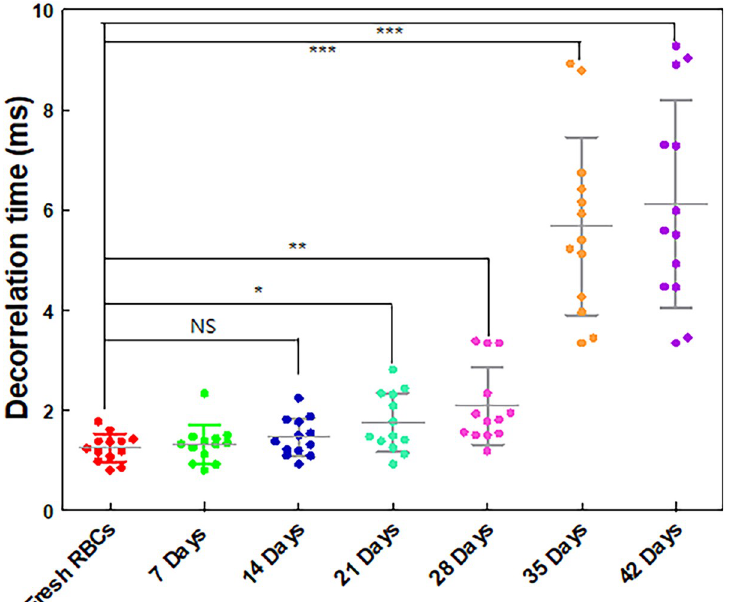
Fig 3. Speckle decorrelation times (SDTs) of stored RBCs with respect to storage duration. The decorrelation times of each group were 1.26 ± 0.27 ms, 1.32 ± 0.36 ms, 1.47 ± 0.37 ms, 1.76 ± 0.56 ms, 2.10 ± 0.74 ms, 5.68 ± 1.71 ms, and